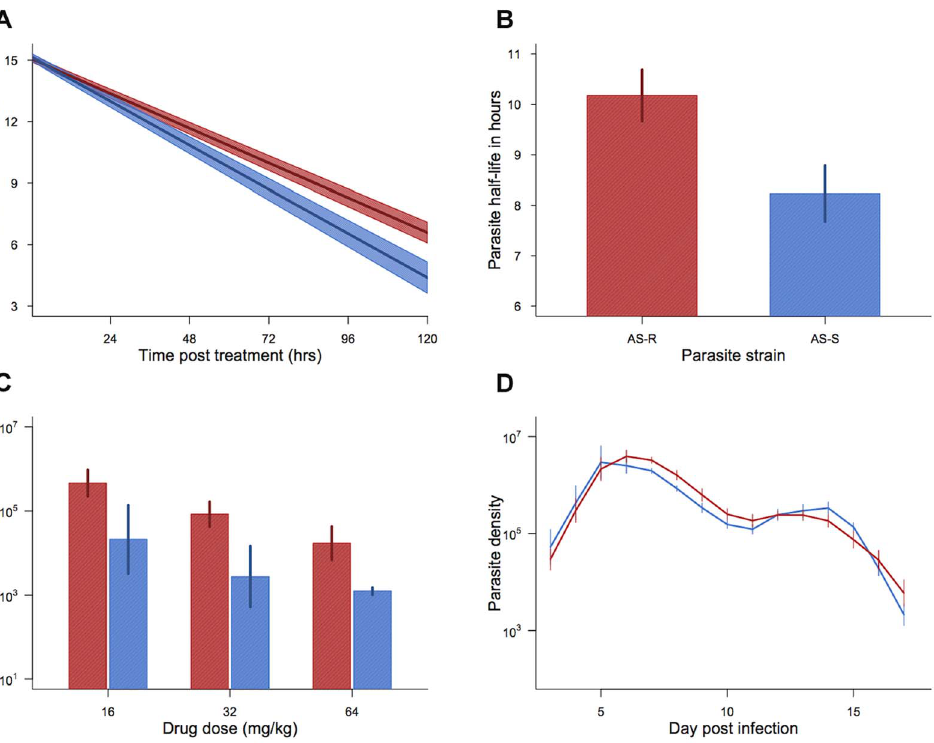
Figure 2. Resistance phenotype and parasite dynamics. Parasite clearance curves (a), half-lives (b), cumulative density in the week post treatment (c), and dynamics in the absence of drugs (d) for drug-selected line (AS117P(art) shown in red) and control line (AS109P(s) shown in blue). Bars (b–d) and shaded area (a) show the standard error of the mean. Mean from 19 infections per line (a & b) and 5–7 infections per combination (c) and 7 infections per line (d). Data from experiment